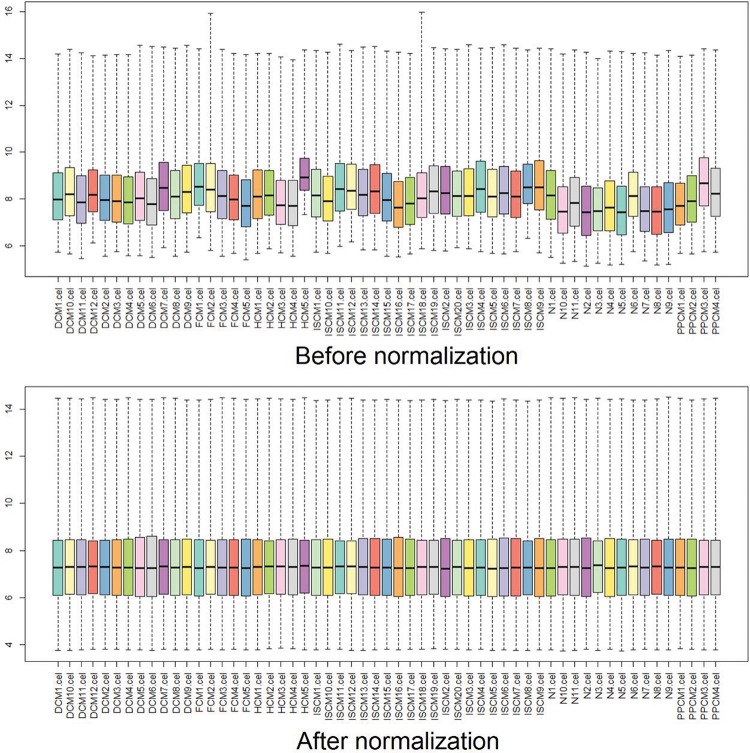
Box plots for the expression value data before and after normalization. The horizontal axis indicates the different samples, and the vertical axis represents the expression values of the genes. The black line in each box is the median of the expression value. Before normalization, the median gene expression value in each box was not at the same level. After normalization, the median of the expression value was almost on the same line, suggesting an excellent performance of the normalization.